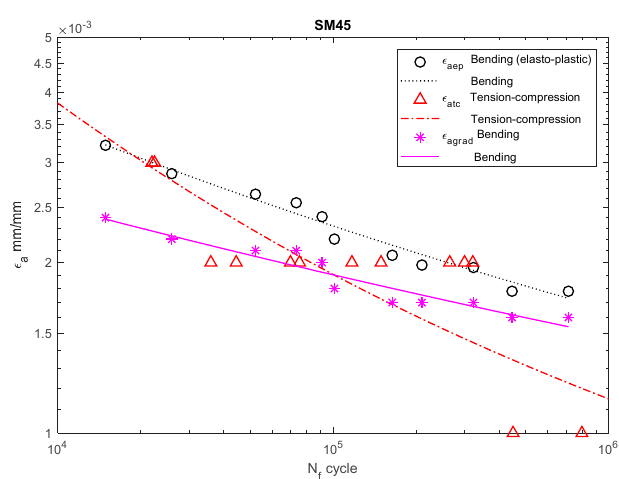
Figure 8. Dependency chart for the strain amplitude ε a = f(N f ) for SM45 steel.